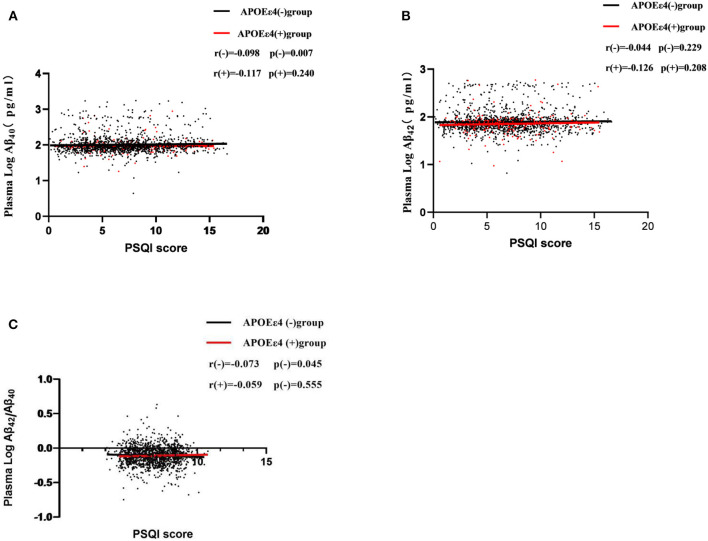
Partial correlations of sleep scores (PSQI score) and plasma Aβ levels according APOE ε4 status. Participants were divided into two groups: APOE ε4 carriers and non-carriers, which are represented by red dots and black dots.